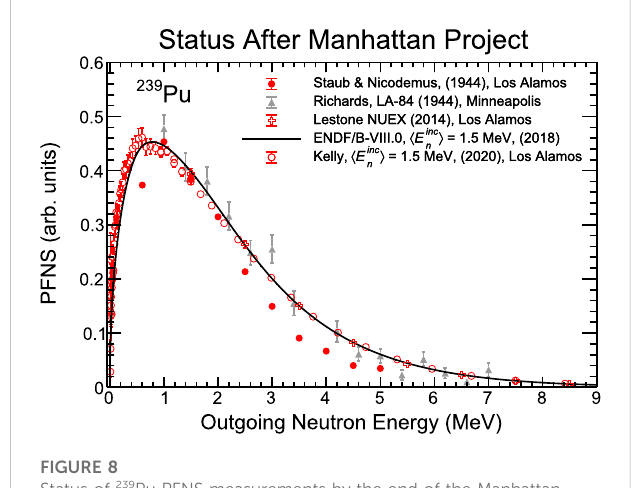
Status of 239 Pu PFNS measurements by the end of the Manhattan